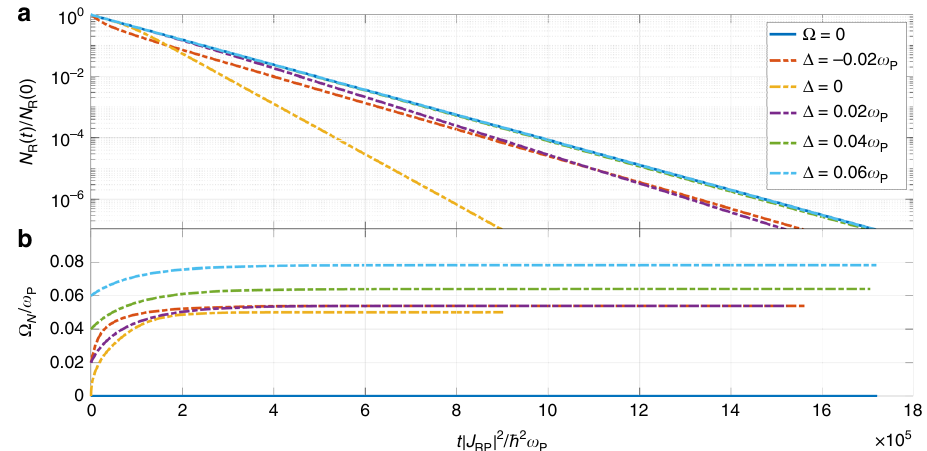
Fig. 5 Evolution of reactant consumption. a Integrated rate law for the reaction outside and inside of the cavity at several detunings. The departure of the VSC enhanced kinetics with respect to the bare case becomes more signi fi cant at resonance. b Evolution of effective Rabi splittings as the reaction progresses. The effects on the kinetics are observed when the VSC regime ( Ω N > 0 : 01 ω k T ¼ 0 : 2 _ ω , and E z 3 : 5 _ ω 001 ¼ B P P